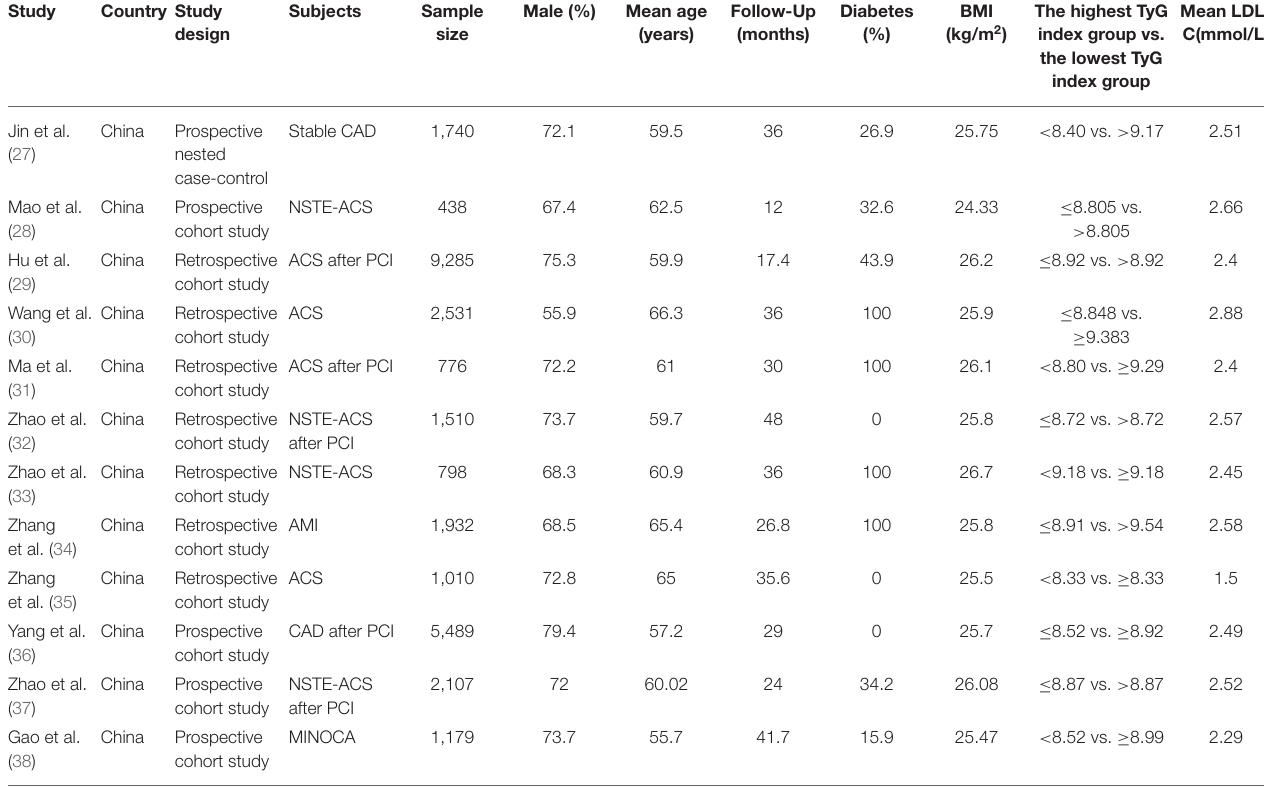
TABLE 1 | Characteristics of participants in the 12 included